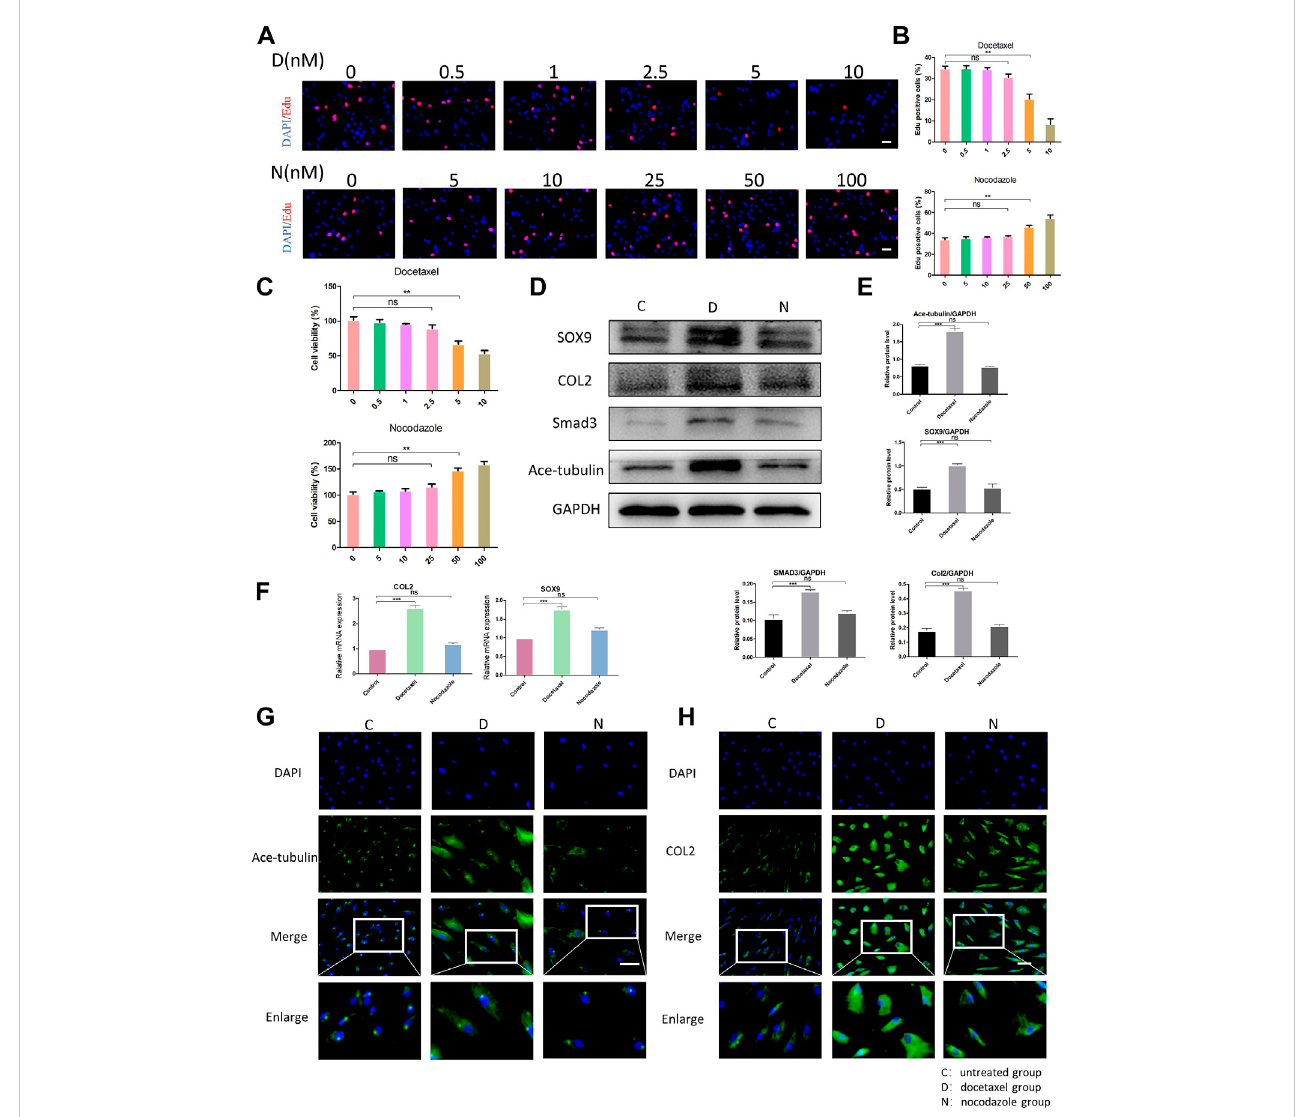
FIGURE 2 The effect of microtubule (MT) stabilization in the synthesis of COL2 in NP cells. (A) The EdU staining of degenerated NP cells after the treatment of different concentrations of docetaxel (D) (0.5, 1, 2.5, 5, 10 nM) and nocodazole (N) (5, 10, 25, 50, 100 nM) for 1 week. Scale bar, 100 µm. (B) Quanti fi cation of the data of (A) . n = 4. (C) Cell Counting Kit-8 Assay is used to detect cell viability. The cell viability of NP cells after the treatment of different concentrations of docetaxel (0.5, 1, 2.5, 5, 10 nM) and nocodazole (5, 10, 25, 50, 100 nM) for 1 week. n = 4. (D) Western blot analysis of Ace-Tubulin, COL2, SOX9, and SMAD3 expression in NP cells treated with docetaxel and nocodazole for 1 week. (E) Quanti fi cation of the data of (D) . n = 4. (F) Quantitative real time polymerase chain reaction (Q-PCR) of COL2 and SOX9 expression in NPCs treated with docetaxel and nocodazole for 1 week. (G, H) Cell immuno fl uorescencestainingofAce-TubulinandCOL2expressioninNPcellstreatedwithdocetaxelandnocodazolefor1 week.Scalebar,100 µm.Dataare represented as the mean ± SEM. * p < 0.05, ** p < 0.01, *** p <